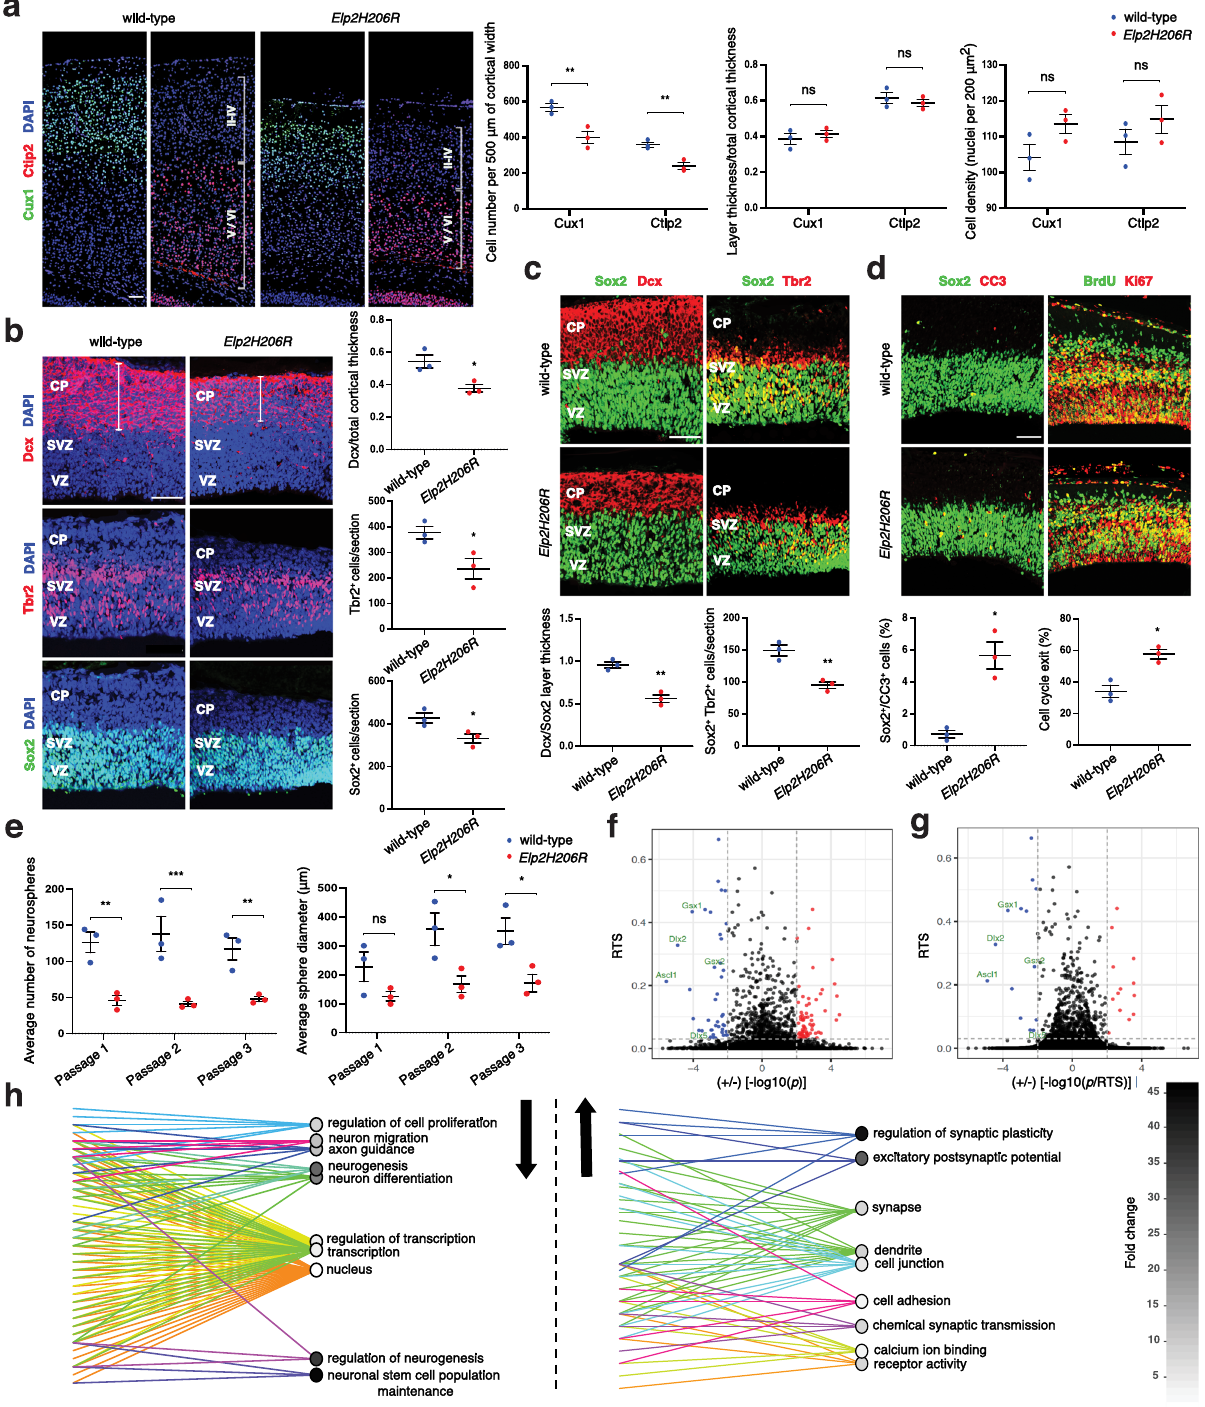
organization in the Elp2H206R brains by co-immuno fl uorescence staining of Cux1 (upper layers II-IV) and Ctip2 (deep layers V and VI). Quanti fi cation of the somatosensory cortex revealed a signi fi cant and proportional decrease in both upper and deep cortical layers in the Elp2 mutants in comparison to the littermate controls (Fig. 7a). Thus, the reduction of the cortical thickness results from an overall decrease in neuron number across all cortical layers, while maintaining a normal cellular distribution and laminar organization.